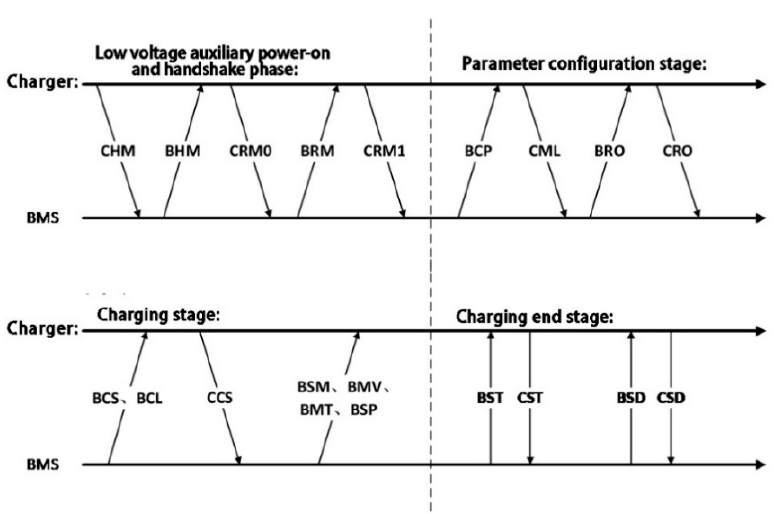
Figure 8. Message process at each stage of charging. Refer to Table 1 for the content of each message code. Table 1. Message content table of electric vehicle charging communication system.